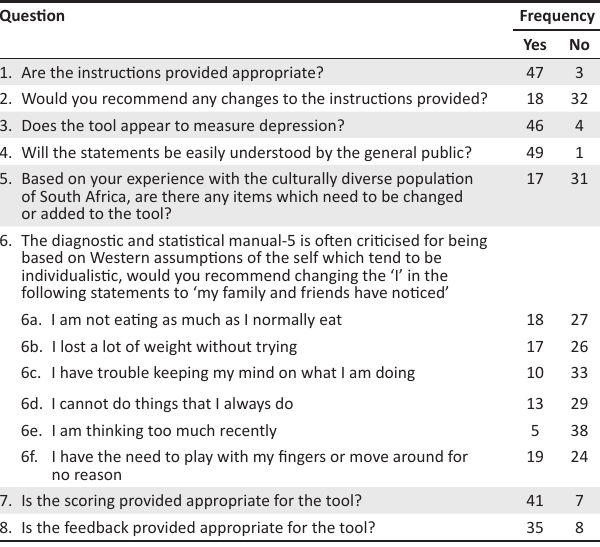
TABLE 3: Questions provided to participants and the frequencies of responses in study one.